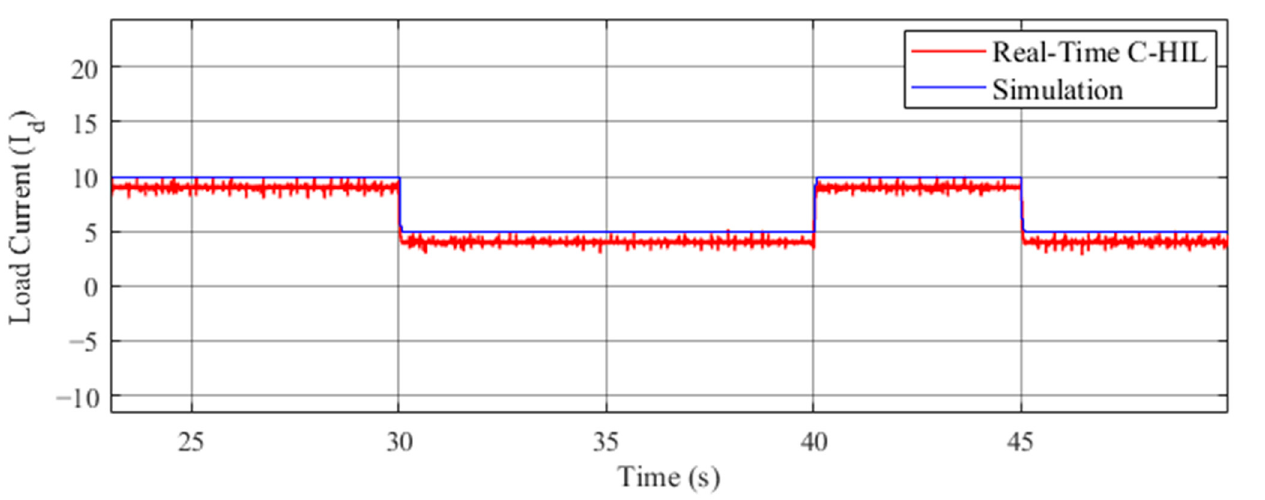
Figure 27. System load current.